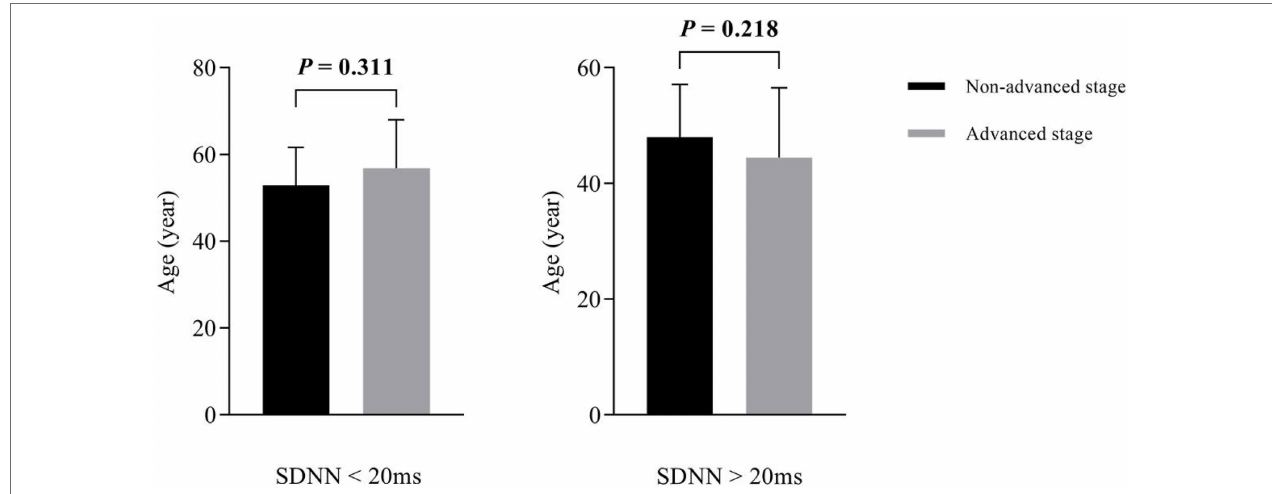
FIGURE 1 | Subgroup analysis of age between non-advanced and advanced groups.